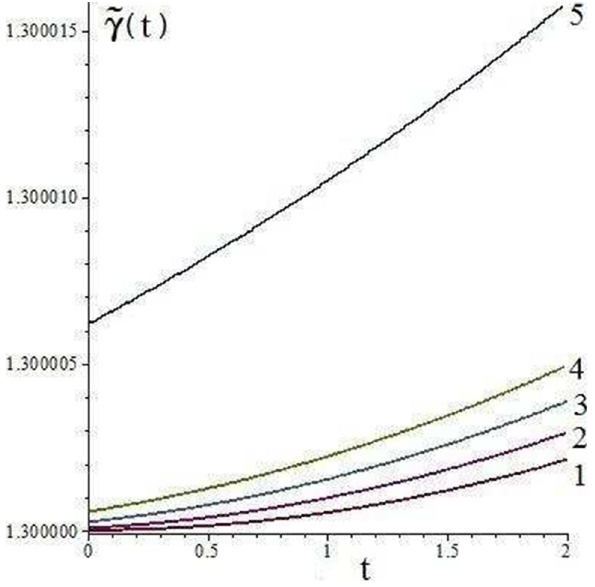
Fig. 3 Functions ˜ γ( t ) for ω = 0 . 01, V = 0 . 2 and a = 0 (1), a = 1 (2), a = 2 (3), a = 3 (4) and a = 6